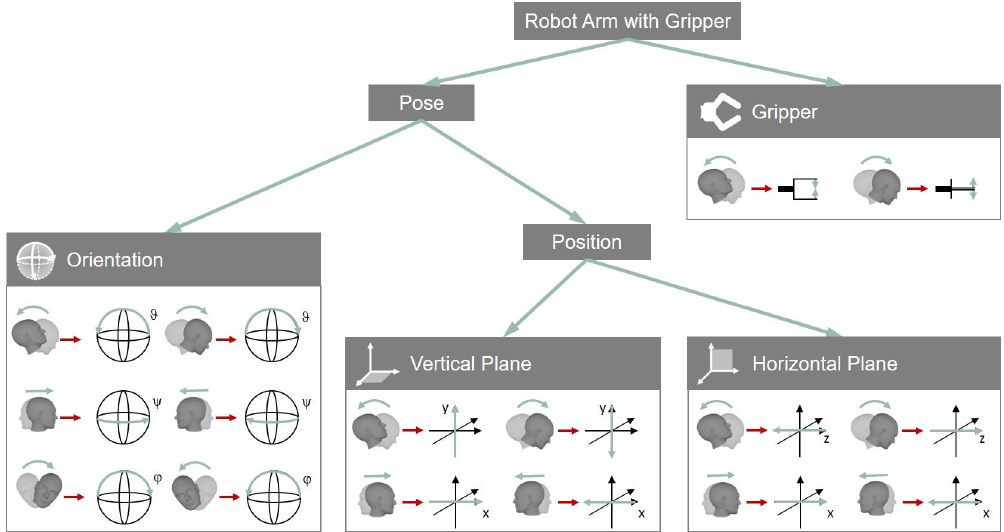
Figure 3. Mapping of head DOFs onto robot DOFs. Four different groups, that is, Gripper, Orientation, Vertical Plane and Horizontal Plane, are depicted. The user is able to switch between groups in order to control all DOFs of the